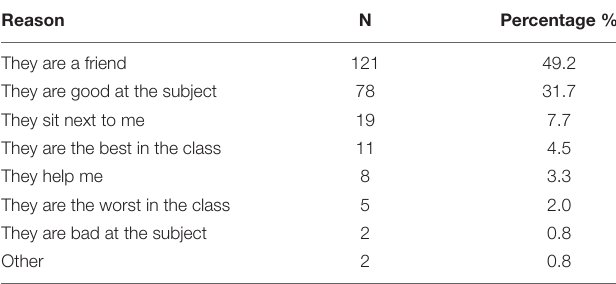
TABLE 1 | Reasons for selection of social comparison target.